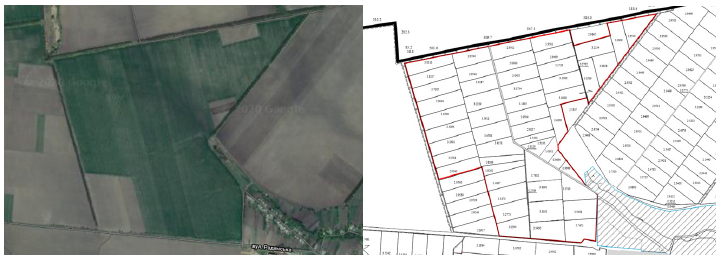
Figure 5. Land plots placement and usage within the first land mass (source: